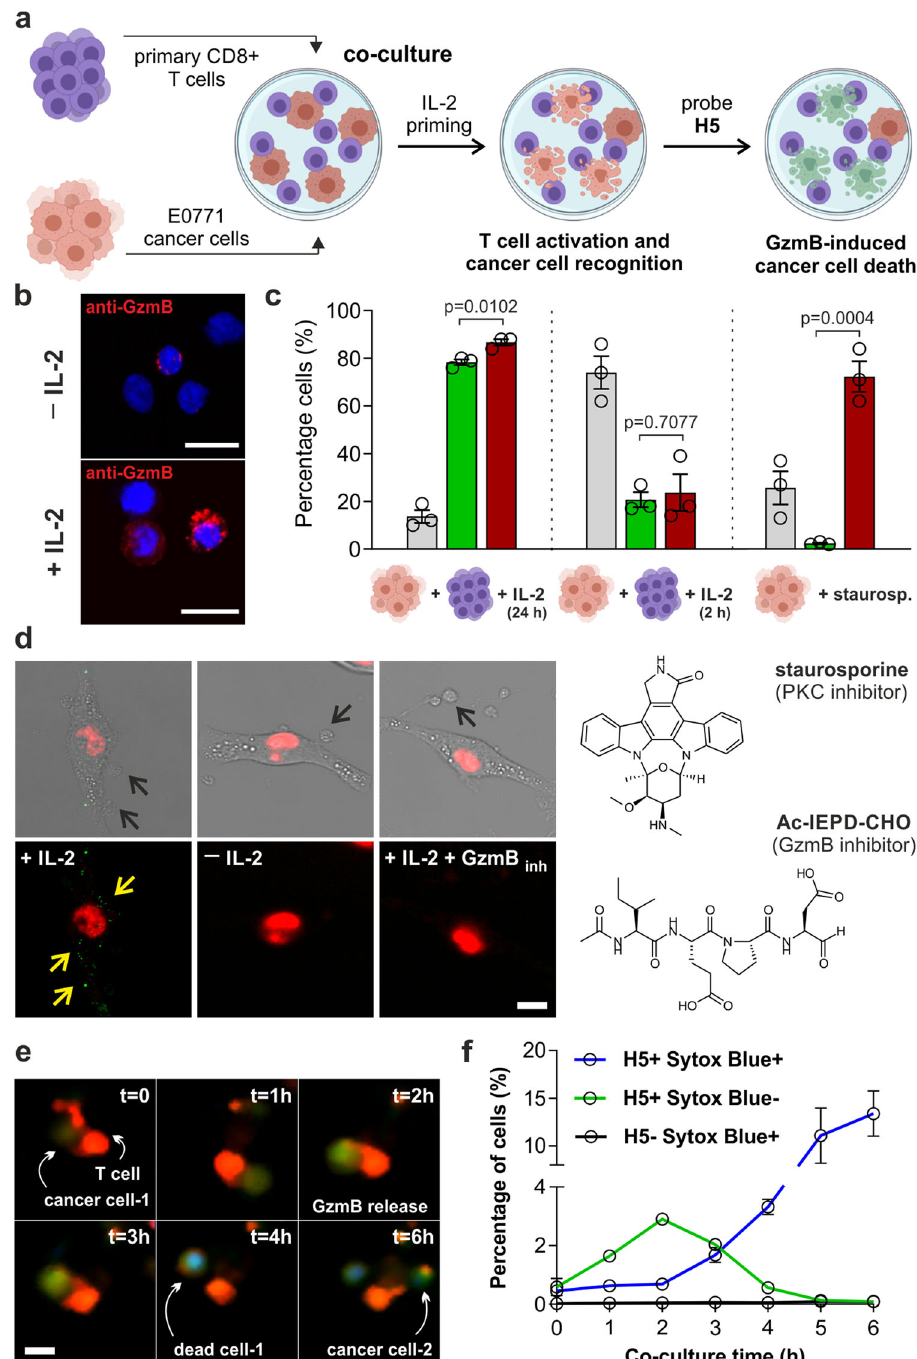
Fig. 2 Probe H5 detects GzmB-mediated anticancer activity of CD8 + T cells. a Schematic procedure for co-culture assays. b Representative microscopy images of CD8 + T cells before/after reinvigoration and staining by anti-GzmB (10 nM, red) and Hoechst 33342 (1 µ M, blue) ( n = 3). Scale bar: 10 μ m. c Flow cytometry (gating: Fig. S7) of E0771 cells in co-culture with active (IL-2, 24 h) or inactive (IL-2, 2 h) CD8 + T cells, or alone with staurosporine (1 μ M, 1 h). Legends: viable (gray), H5 -stained (green), apoptotic (red). H5 (5 μ M), Annexin V-AF647 (10 nM). Data as means ± SEM ( n = 3). d Confocal microscopy of mKate-expressing E0771 cancer cells (red) stained with H5 (25 μ M, green) in co-culture with active T cells (left), non-active T cells (centre), or active T cells plus Ac-IEPD-CHO (right). Black arrows highlight T cells, yellow arrows highlight H5 -stained intracellular GzmB puncta. Quanti fi cation of fl uorescence intensity by image analysis shown in Fig. S8. Scale bar: 10 μ m. e Time-course fl uorescence microscopy of OT-I CD8 + T cells stained with Cell Tracker Orange (red) killing OVA-EL4 cancer cells in the presence of H5 (10 μ M, green) and Sytox Blue (1 μ M, blue) ( n = 3). Scale bar: 10 μ m. f Flow cytometric analysis of OVA-EL4 cancer cells from experiments in e . Data as means ± SEM ( n = 3). P- values from two-tailed t- tests. Source data ( c , f ) provided as a Source Data fi